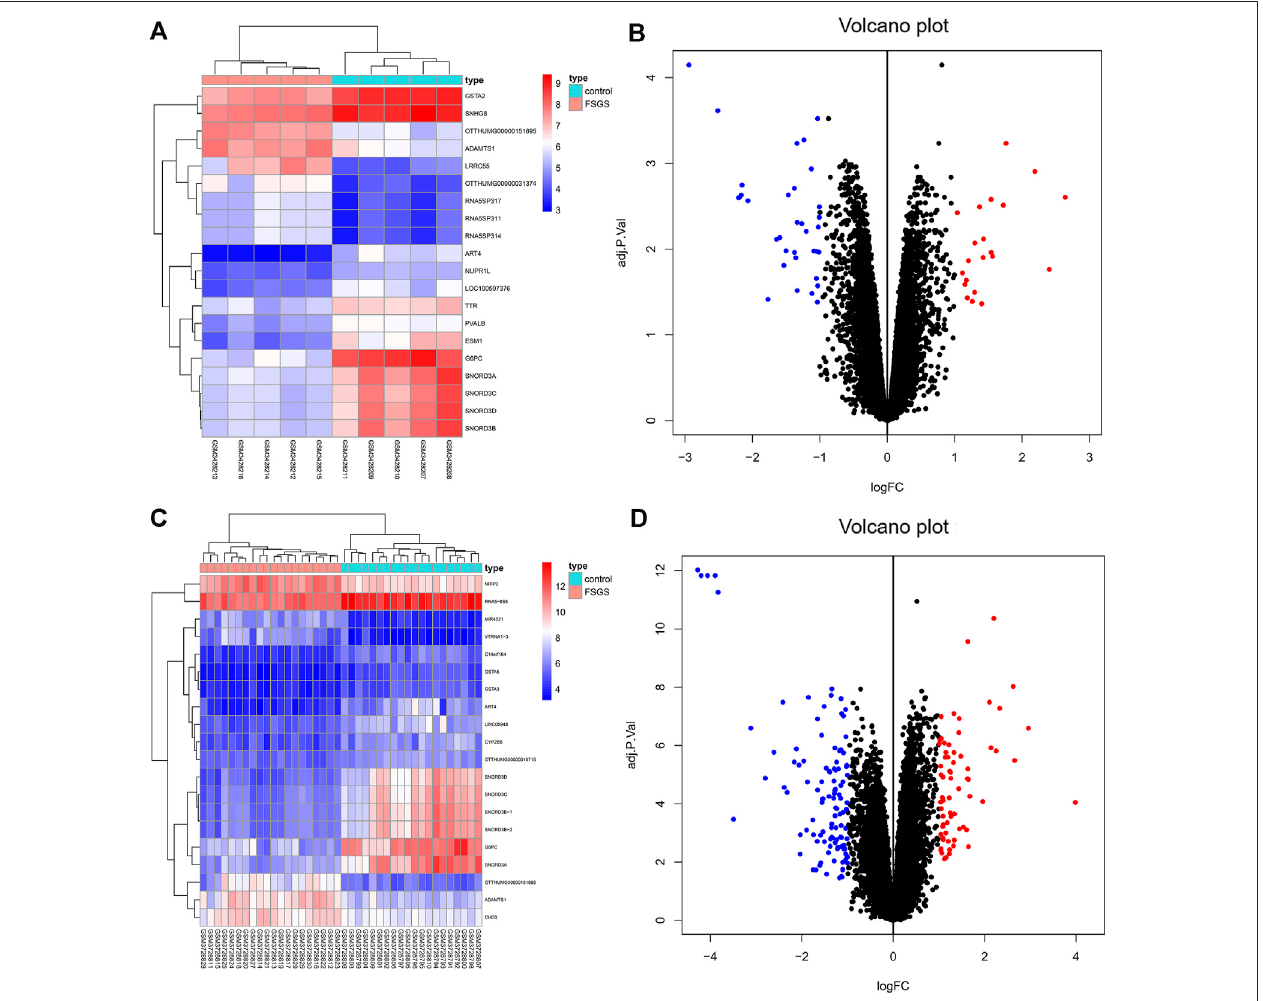
FIGURE 1 | Heatmap (A) and volcano plot (B) of GSE121233 DEGs. Heatmap (C) and volcano plot (D) of GSE129973 DEGs. The heatmap visually shows the difference in gene expression between the FSGS group and the healthy control group. Each dot in the volcano map represents a gene. Blue represents downregulated genes, and red represents upregulated genes. Abbreviations: DEGs, differential expression